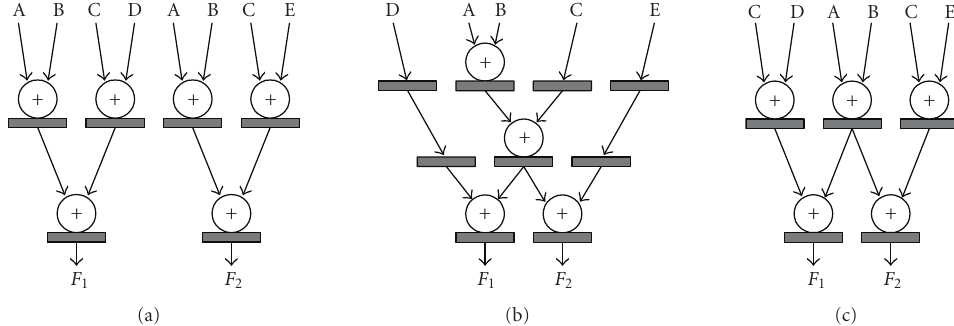
Figure 6: Extracting common subexpression (a) Unoptimized expression trees. (b) Extracting common expression (A + B + C) results in higher cost due to inserting additional synchronizing registers. (c) A more careful extraction of common subexpression (A + B) applied by our modified CSE algorithm results in lower cost.